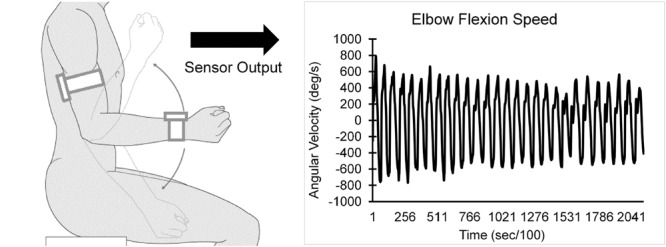
UEF experimental setup and sensor output (i.e., elbow angular velocity).